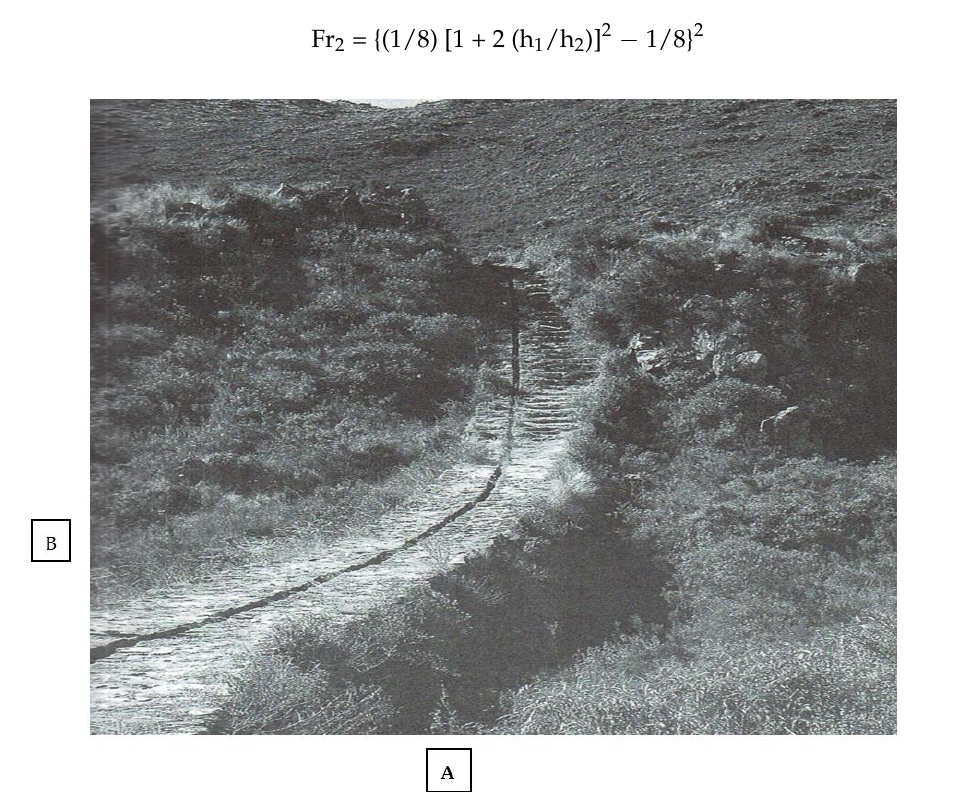
Figure 16. Main Aqueduct Canal Section 4 showing the steep sloped channel section and adjacent stairways. Hydraulic jump occurs at midpoint in figure where channel angle changes from steep to a mild, near horizontal slope. The channel section shown is part of the ‘aqueducto’ (Figure 1) that supplies water to the terraces (Figure 2) and is located near to the Plaza Ceremonial (Figure 1). Coordinate locations, vertical from A, horizontal from B, give the location of the hydraulic jump. (Photo by C. Ortloff).